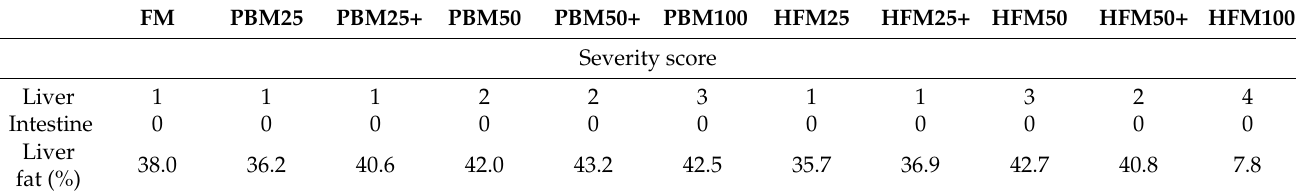
Table 1. Severity score (0–4) for the observed histopathological alterations and liver fat (% of dry weight) in S . aurata fed the experimental